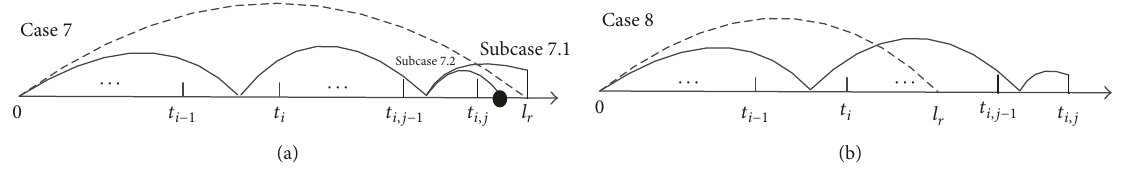
Figure 11: Schematic diagram of case 7 and case 8